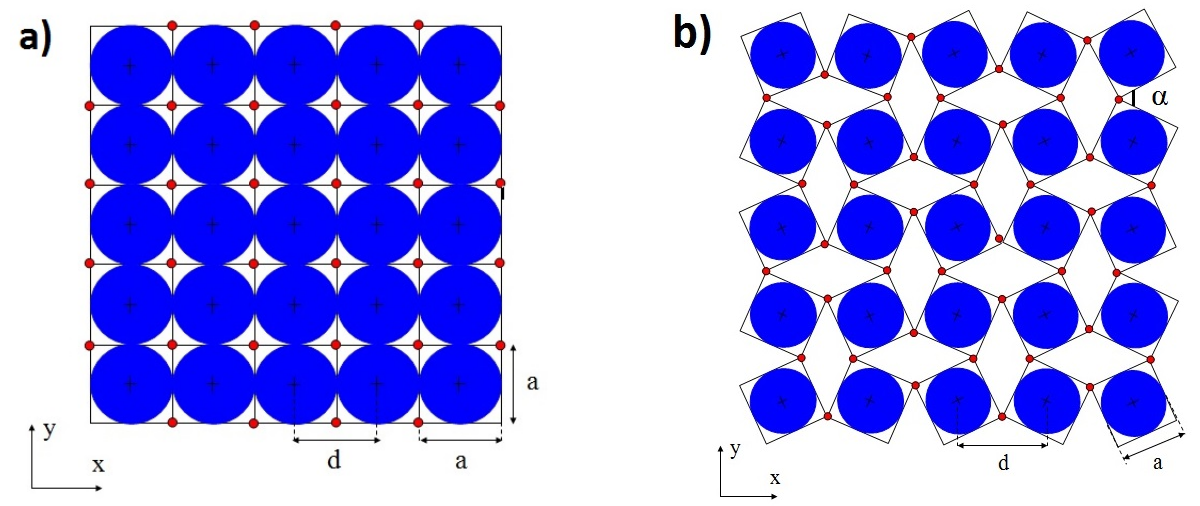
Figure 1. The initial shape of materials has a square structure with a rotation angle α = 0° ( a ), rotation angle α ≠ 0° ( b ).